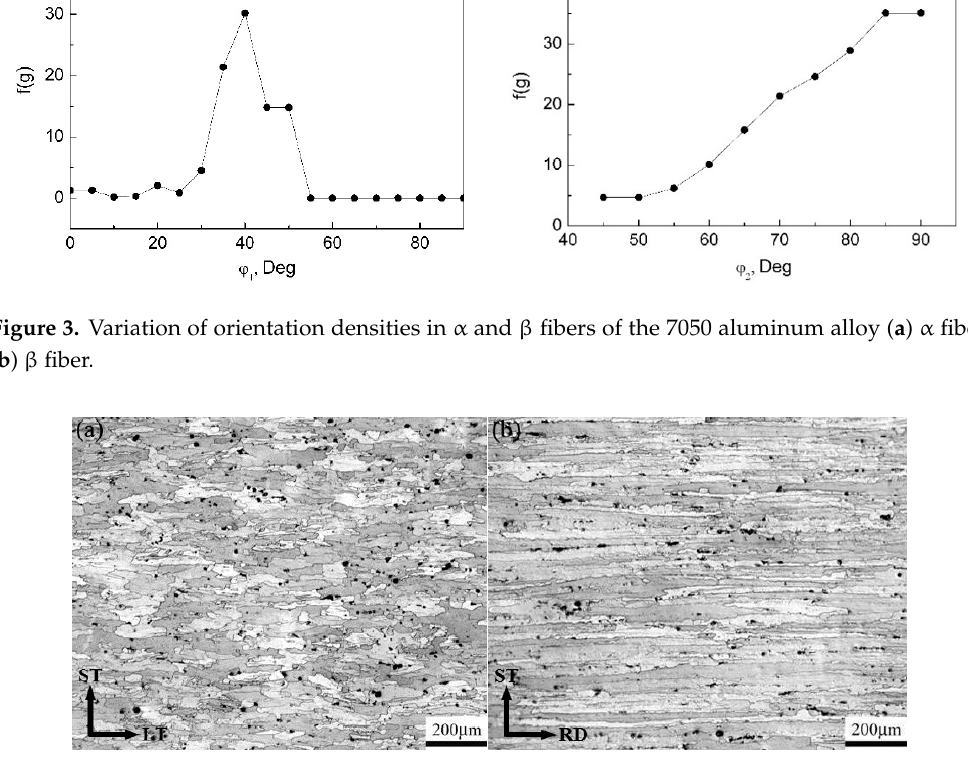
Figure 4. Optical micrographs showing microstructures of the as ‐ quenched 7050 aluminum alloy in ( a ) the transverse plane; ( b ) the longitudinal plane.